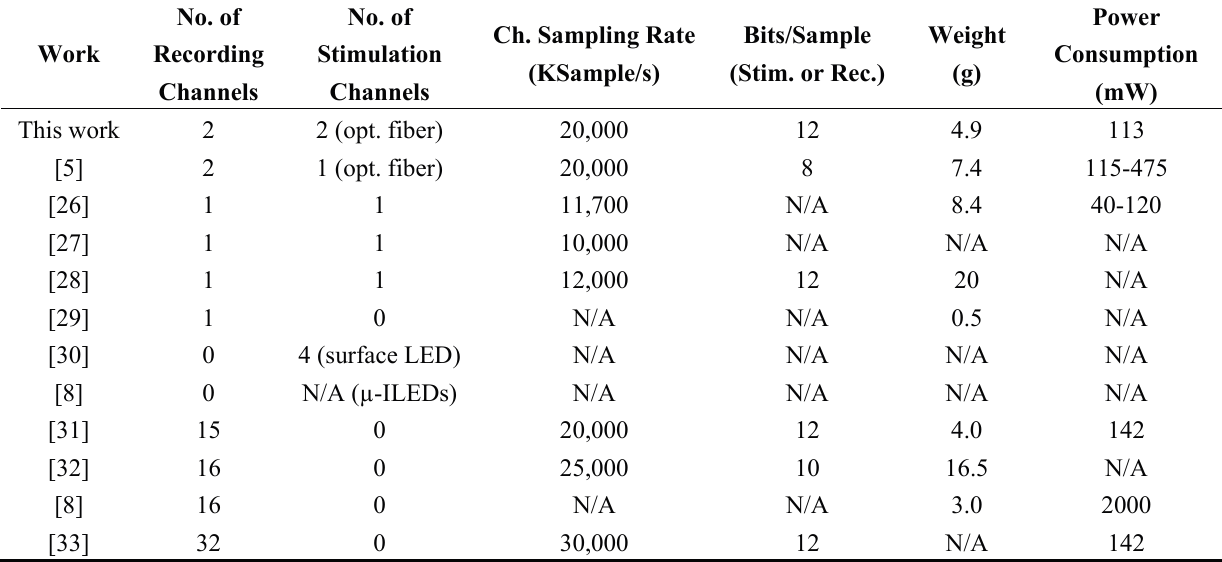
Table 4. Comparison with other wireless commercial off-the-shelf (COTS) headstages.